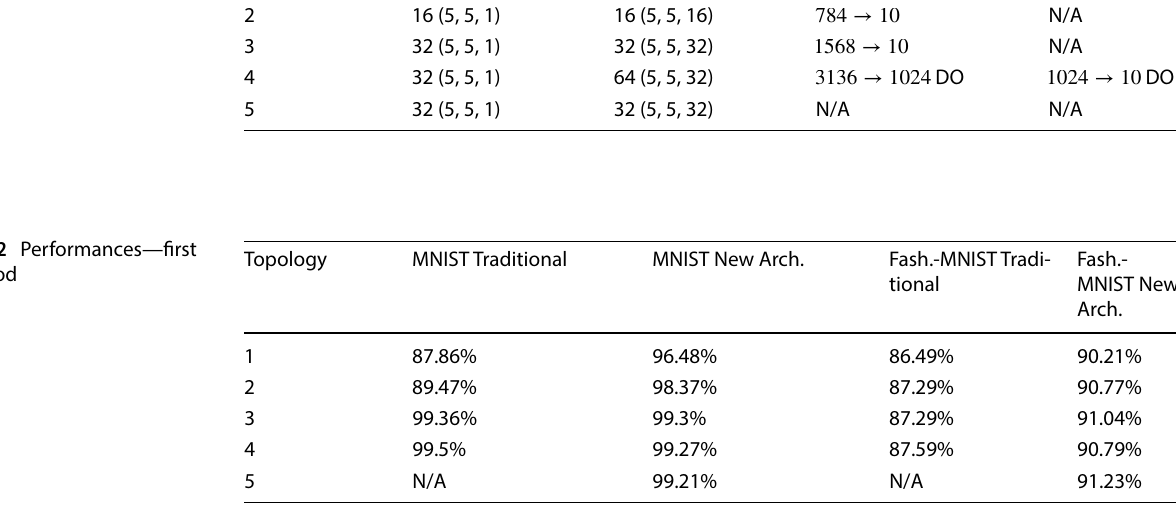
Table 1 Network topologies— first method